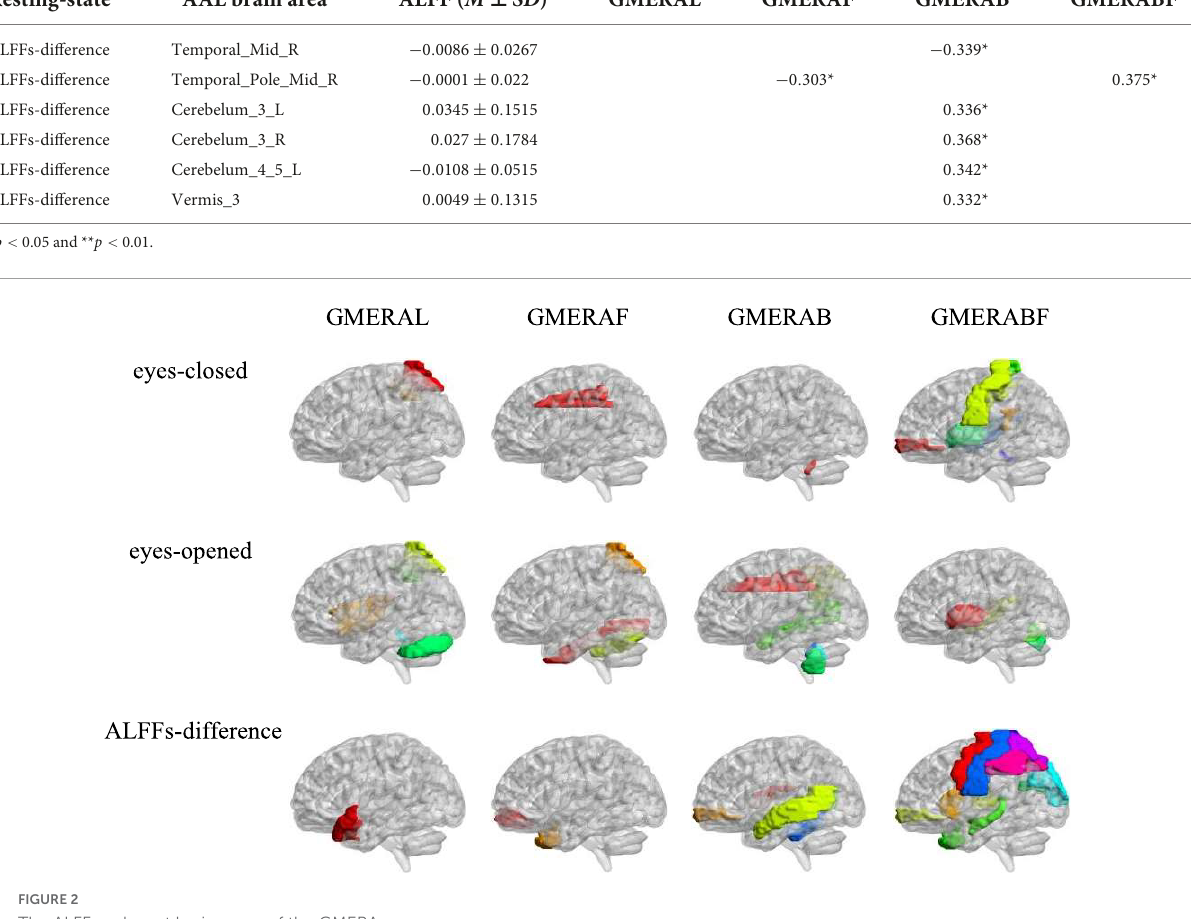
and the motor network for the change from